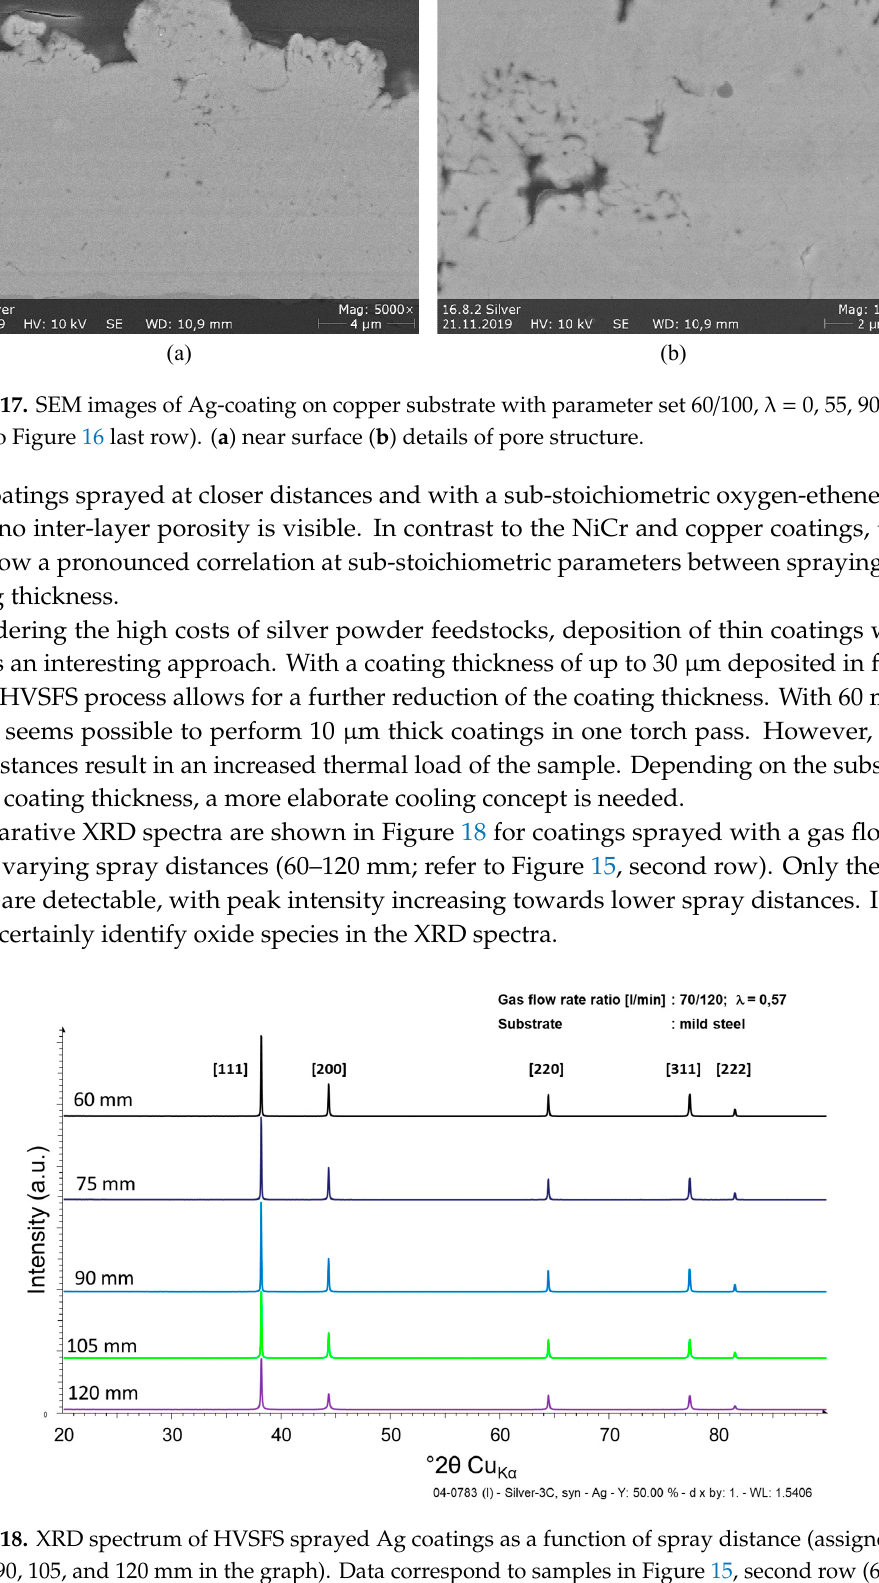
Figure 16. Optical microscope cross-section images of the Ag coatings on mild steel and Cu substrate from samples in Figure 15 chosen for 60, 90, and 120 mm spray distances. Please note that in respect of gas ratios and substrate type, images are organized in the same systematic as in Figure 15.